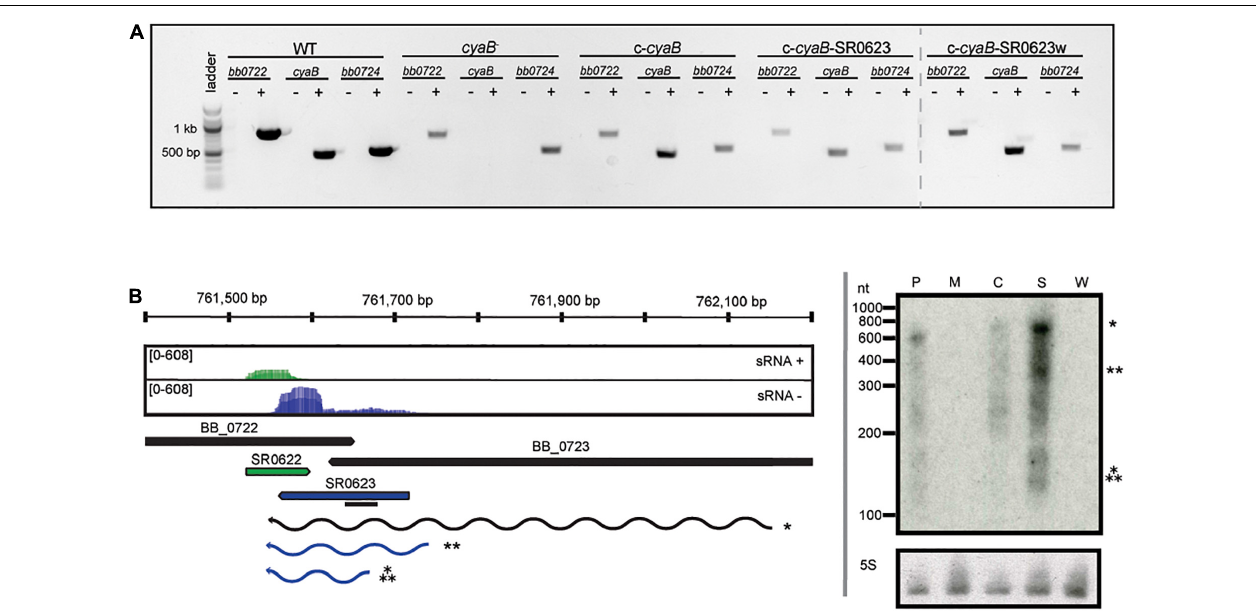
FIGURE 2 | Verification of strains generated in this study. (A) Deletion of cyaB does not abolish transcription of neighboring genes bb0722 or bb0724 . RT-PCR was used to verify the presence or absence of transcripts in the indicated B. burgdorferi strains. RNA was isolated and used to generate cDNA as describe in the Methods . The ± symbols indicate the cDNA reaction with or without reverse transcriptase. PCR reactions included cDNA and primers for cyaB ( bb0723 ), bb0722 , or bb0724 . (B) sRNA-sequencing results are displayed in the coverage map (Popitsch et al., 2017). The + strand is shown in green and the − strand in blue. Northern blot analyses of total RNA fractionated on a 6% denaturing polyacrylamide gel, blotted to a nylon membrane, and hybridized with radioactive oligonucleotides. The black line represents the location of the oligonucleotide probes. The genomic context is indicated below the coverage plot. The predicted transcripts are denoted and marked with the appropriate band in the Northern blot. Northern blots are representative of three biological replicates. The following abbreviations are used to indicate strains: WT (P), cyaB − (M), c- cyaB (C), c- cyaB -SR0623 (S), and c- cyaB -SR0623w